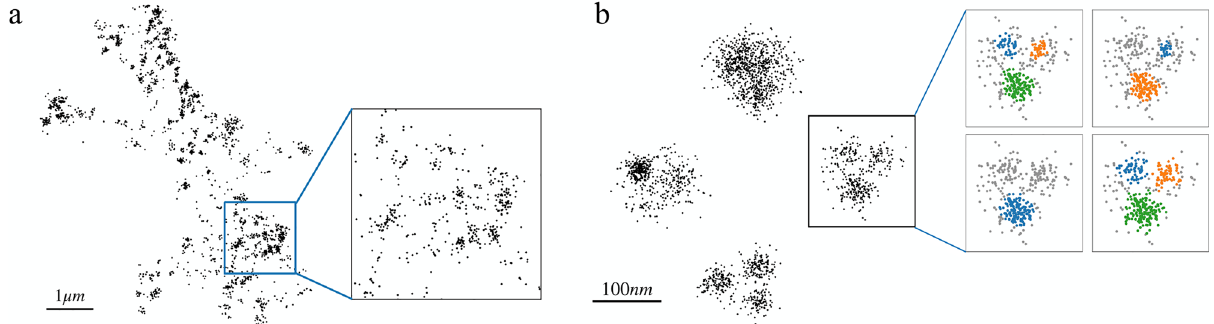
Figure 1. Single-molecule localization microscopy (SMLM) datasets exhibit density variations, noise inclusion and can lead to different cluster analysis results. ( a ) Localizations representing AMPA-receptors in a dendritic segment of a neuron 9 . ( b ) Example of four DNA origami trimers, with different clustering results for